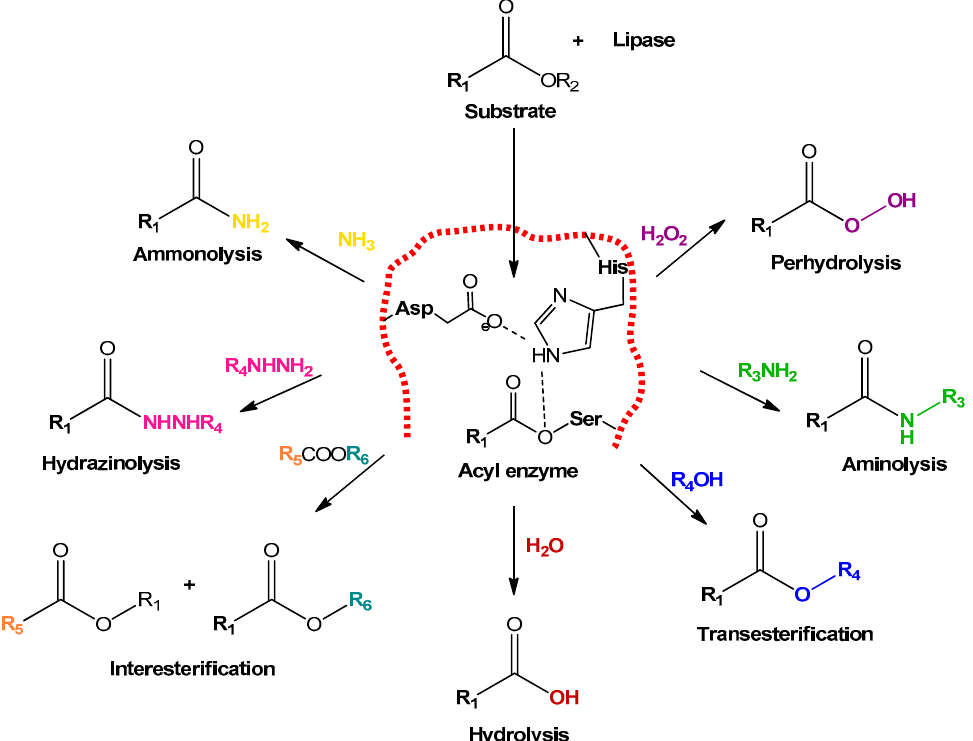
Figure 1. Examples of reactions catalyzed by lipases with different substrates [13].